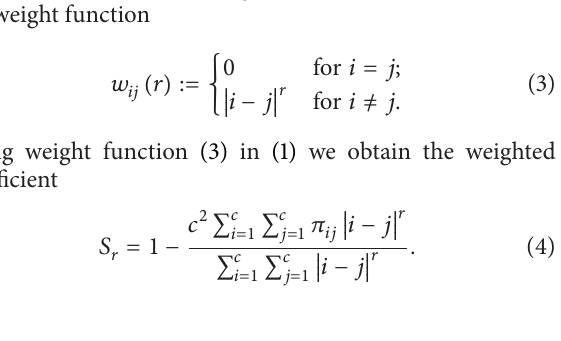
table. Table 1 is an example of an agreement table. The data of Table 1 come from Holmquist et al. [41]. Seven pathologists, labeled A to G, classified each of 118 slides in terms of carcinoma in situ of the uterine cervix, based on the most involved lesion, using ordered categories, (1) negative, (2) atypical squamous hyperplasia, (3) carcinoma in situ, (4) squamous carcinoma with early stromal invasion, and (5) invasive carcinoma. The data can also be found in Landis and Koch [42]. Table 1 is the cross classification of the ratings of pathologists A and